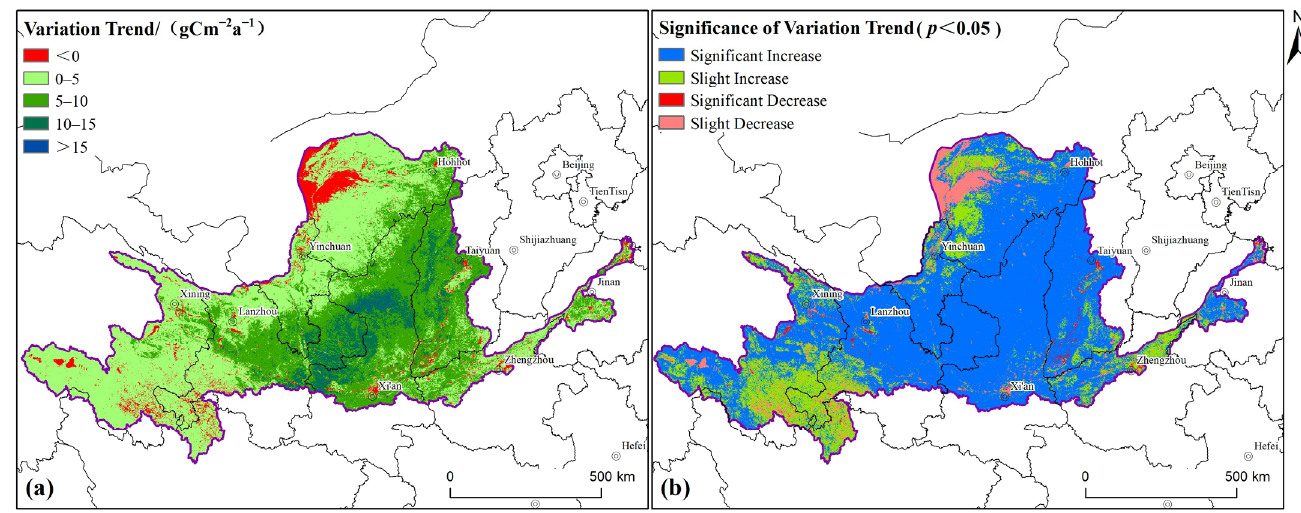
Figure 5. Trend and significance test of NEP (( a ) shows Theil–Sen trend chart of NEP, and ( b ) shows Theil–Sen trend results through MK test). Table 1. The variation trend of NEP in the Yellow River basin.